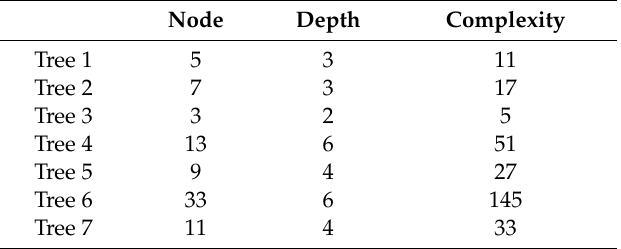
Table 6. Information about Subtrees of Best Model of ABCP-Descriptor for DS-Kylberg. Node Depth